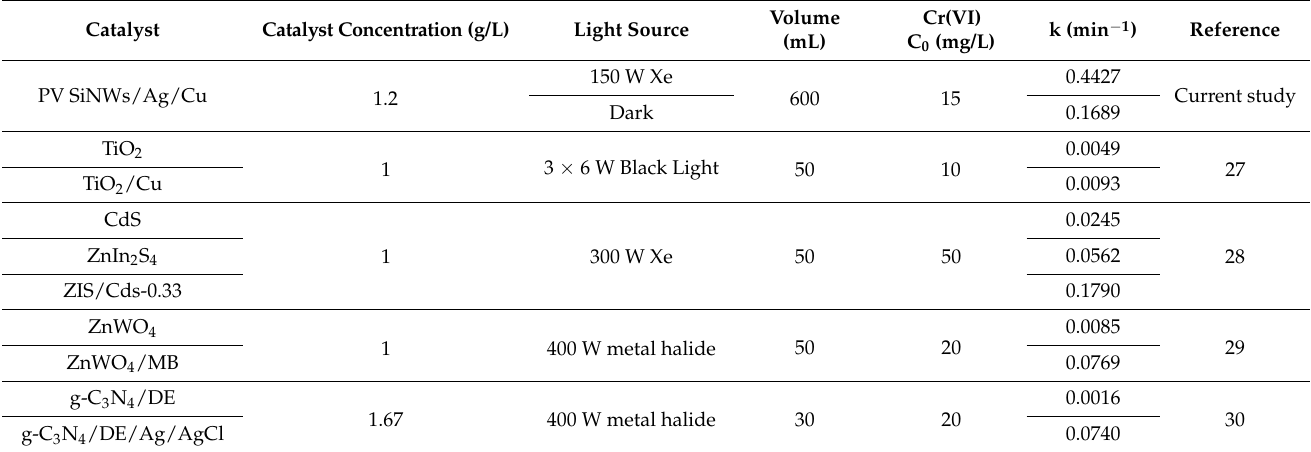
Table 1. Photocatalytic reduction rates of hexavalent chromium in current and previous studies. Catalyst Catalyst Concentration